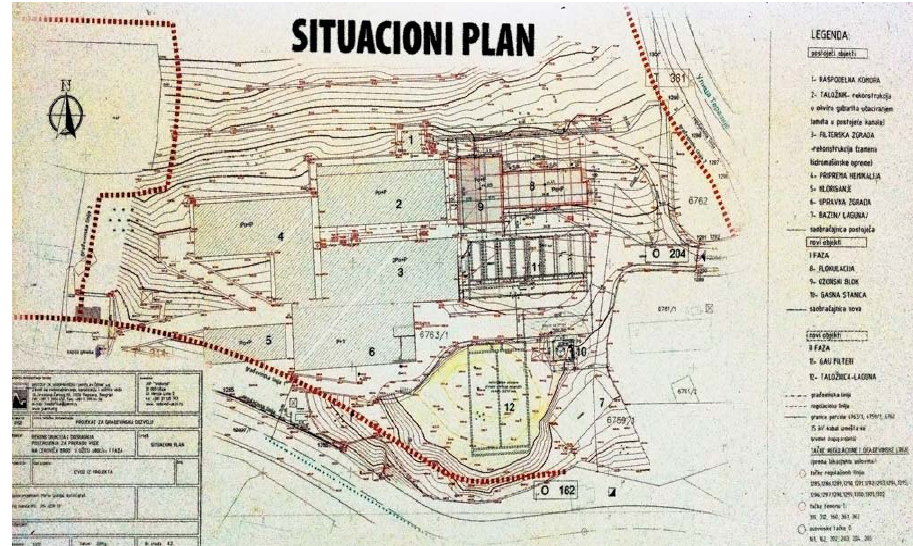
Figure 2 – Situation plan of the water supply plant Рис . 2 – Ситуационный план для водоочистного